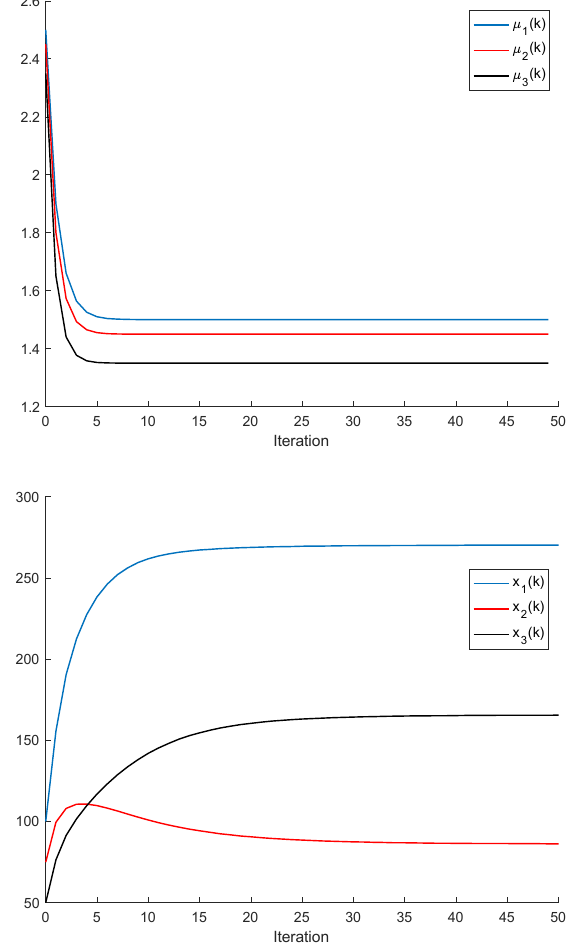
Figure 10. Evolution of x 1 ( k ), x 2 ( k ) and x 3 ( k ) for constant parameters in Example 7 when no harvesting quota nor external consumption are included and growth rates are larger than unity.